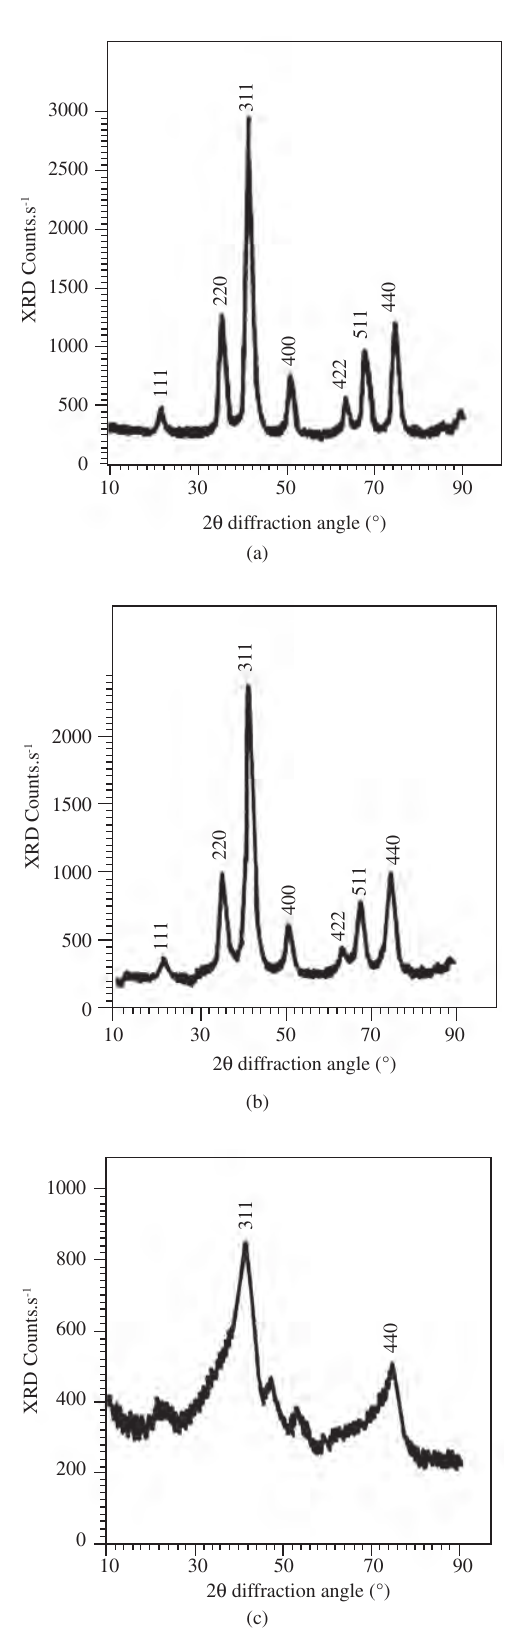
Figure 2. X ray diffraction patterns of cobalt-zinc ferrites prepared by co- precipitation using as precipitation agent: a) NaOH and calcined at 400 °C; b) NH OH and calcined at 400 °C; and c) NaOH and calcined at 200 °C. 4 (calcination time in all cases: